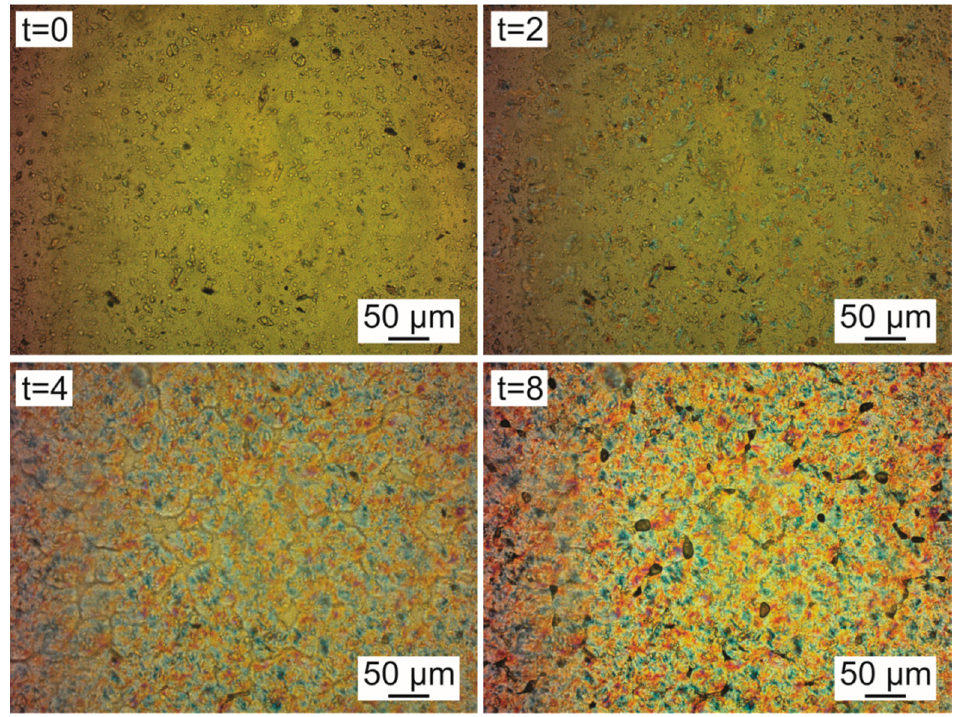
Figure 8. Polarized light optical microscopy images of neat PHBV at 130 °C and times: t = 0; t = 2 min; t = 4 min, and t = 8 min.